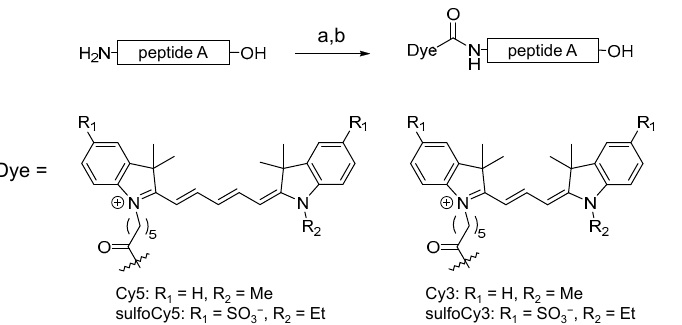
Figure 1. Synthetic scheme of dye-peptide A conjugates. Conditions and reagents: ( a ) Dye-SE, DMSO, 0.1 M Na 2 HPO 4 aq.; ( b ) TFA.